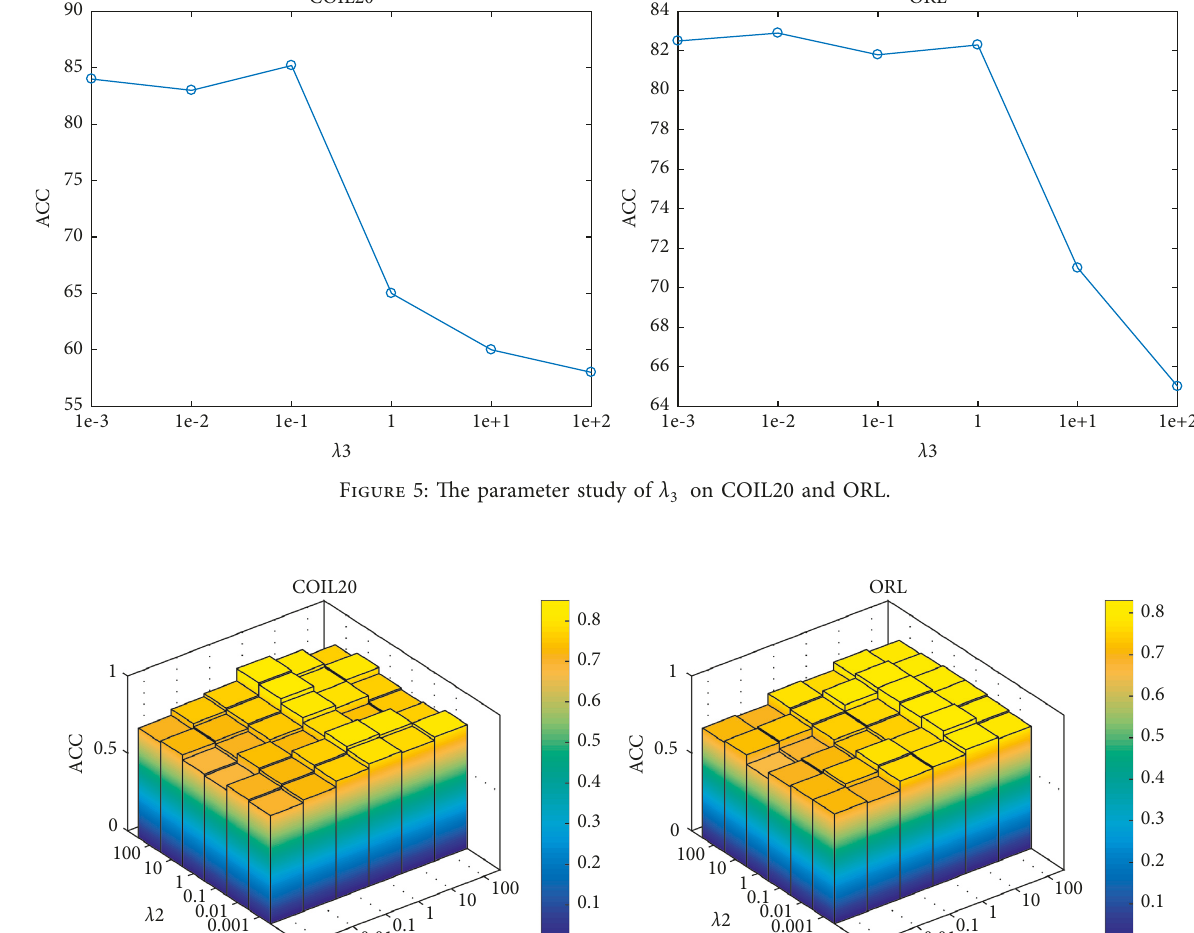
an d λ on COIL20 and 2 3